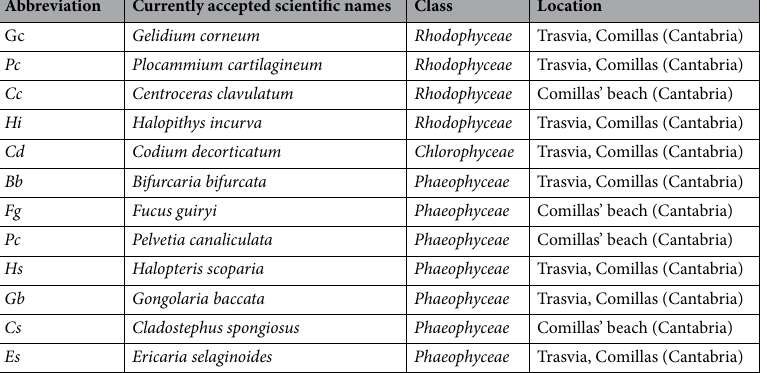
Table 5. Sampling location of macroalgae collected from wild populations on Spain’s north-western